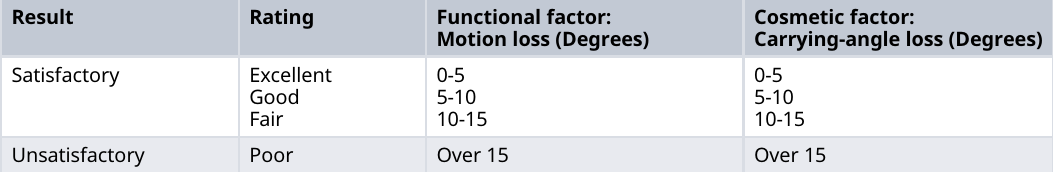
Table 1. Flynn ’ s criteria.